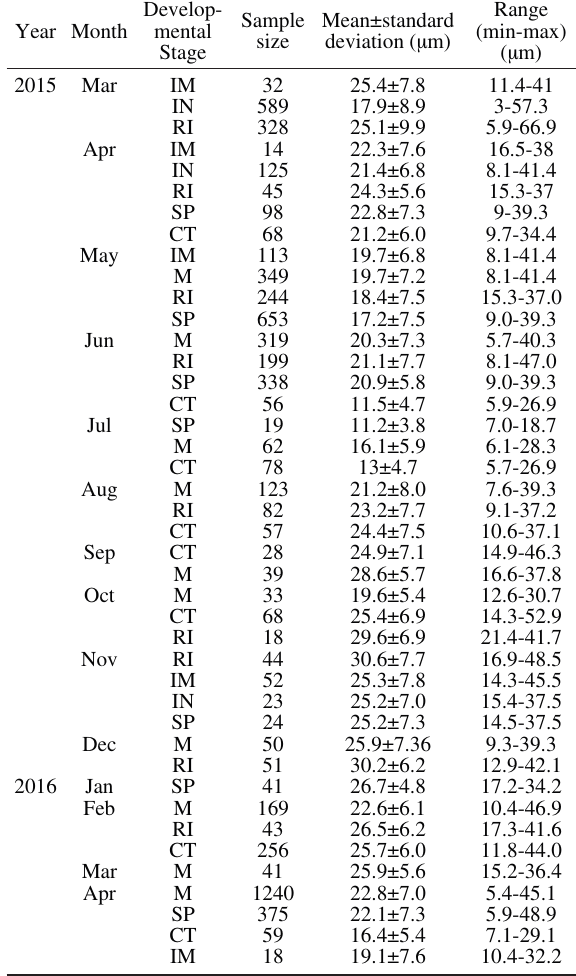
Table 2. – Oocyte diameters of Donax striatus (mean±standard de- viation; min-max). Gonad developmental stages: IM, immature; M, maturation; RI, ripe; SP, spawning; and CT, cytolysis.